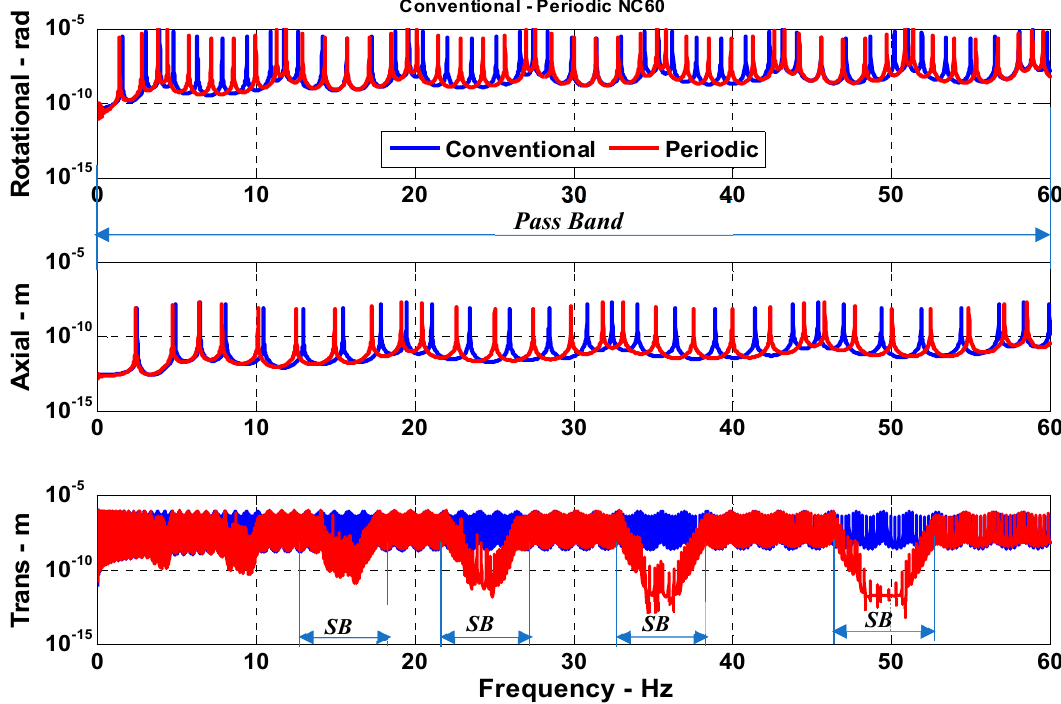
Figure 7. Comparisons between the frequency response characteristics of a conventional drill-string and a drill-string with 60 passive periodic inserts ( SB : Stop band).